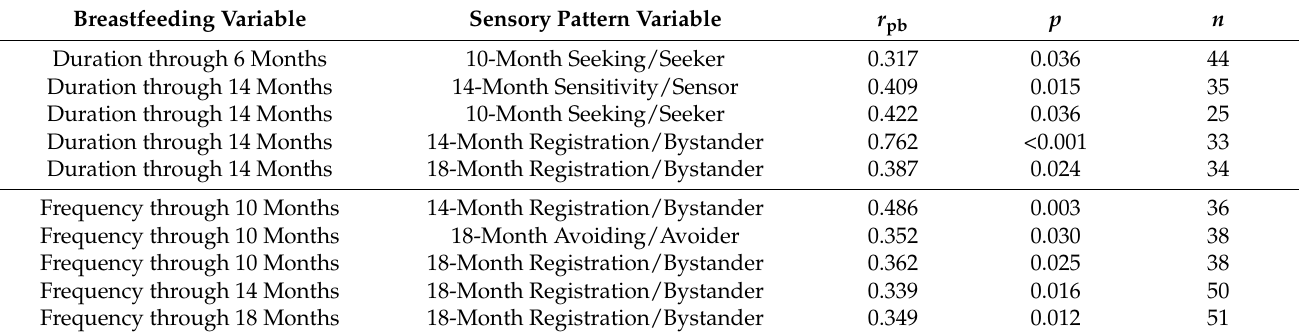
Table 3. Correlations between Breastfeeding Variables and Infant Sensory Patterns; the p -value was set at 0.05. Breastfeeding Variable Sensory Pattern